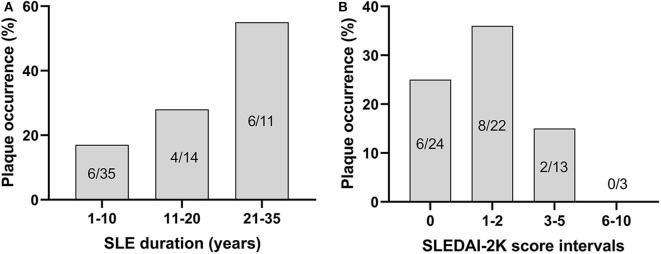
The occurrence of plaques shown in relation to duration of SLE (χ2, p = 0.05) (A) and disease activity, as measured by SLEDAI-2K (not significant) (B).